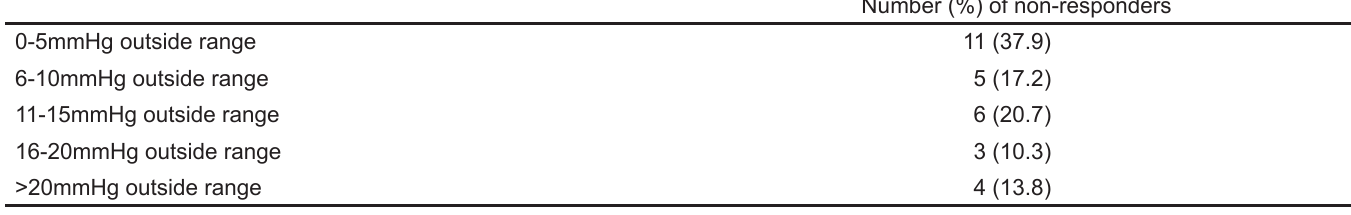
Table 4. Distribution of non-responders by distance outside target range.